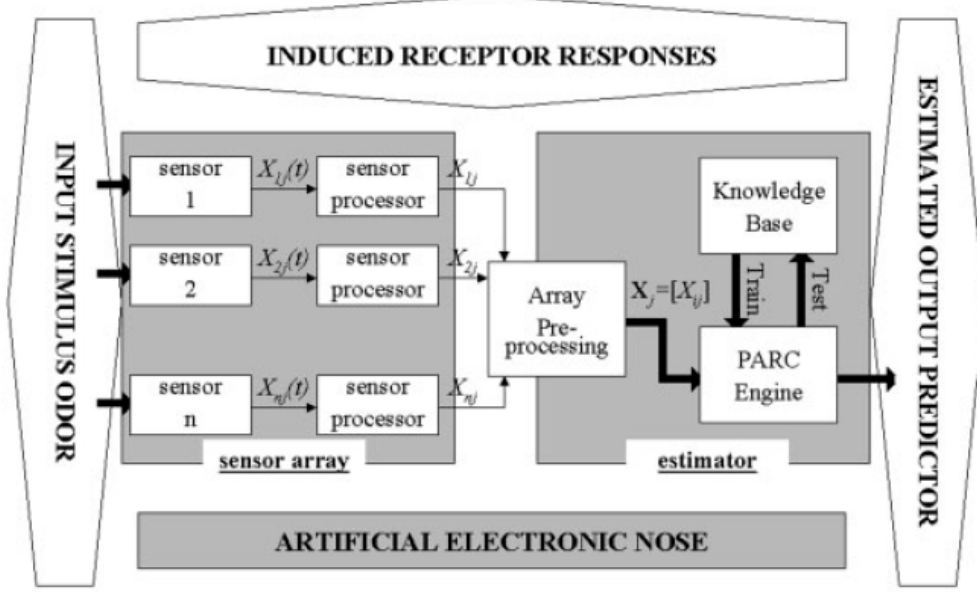
Figure 4. Basic architecture of a data processing system for an